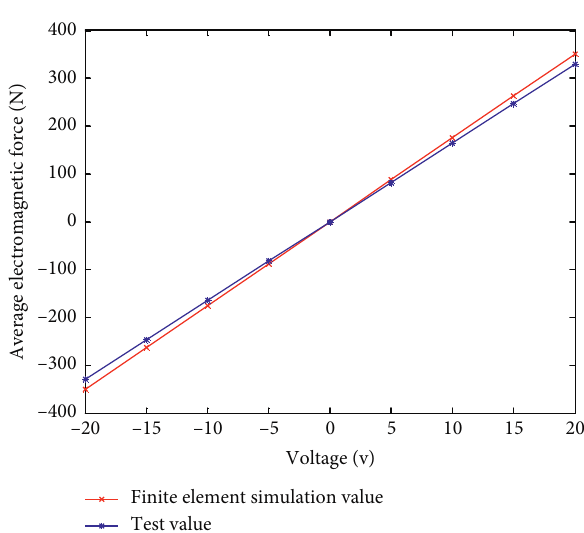
Figure 7: Variation of average electromagnetic force with